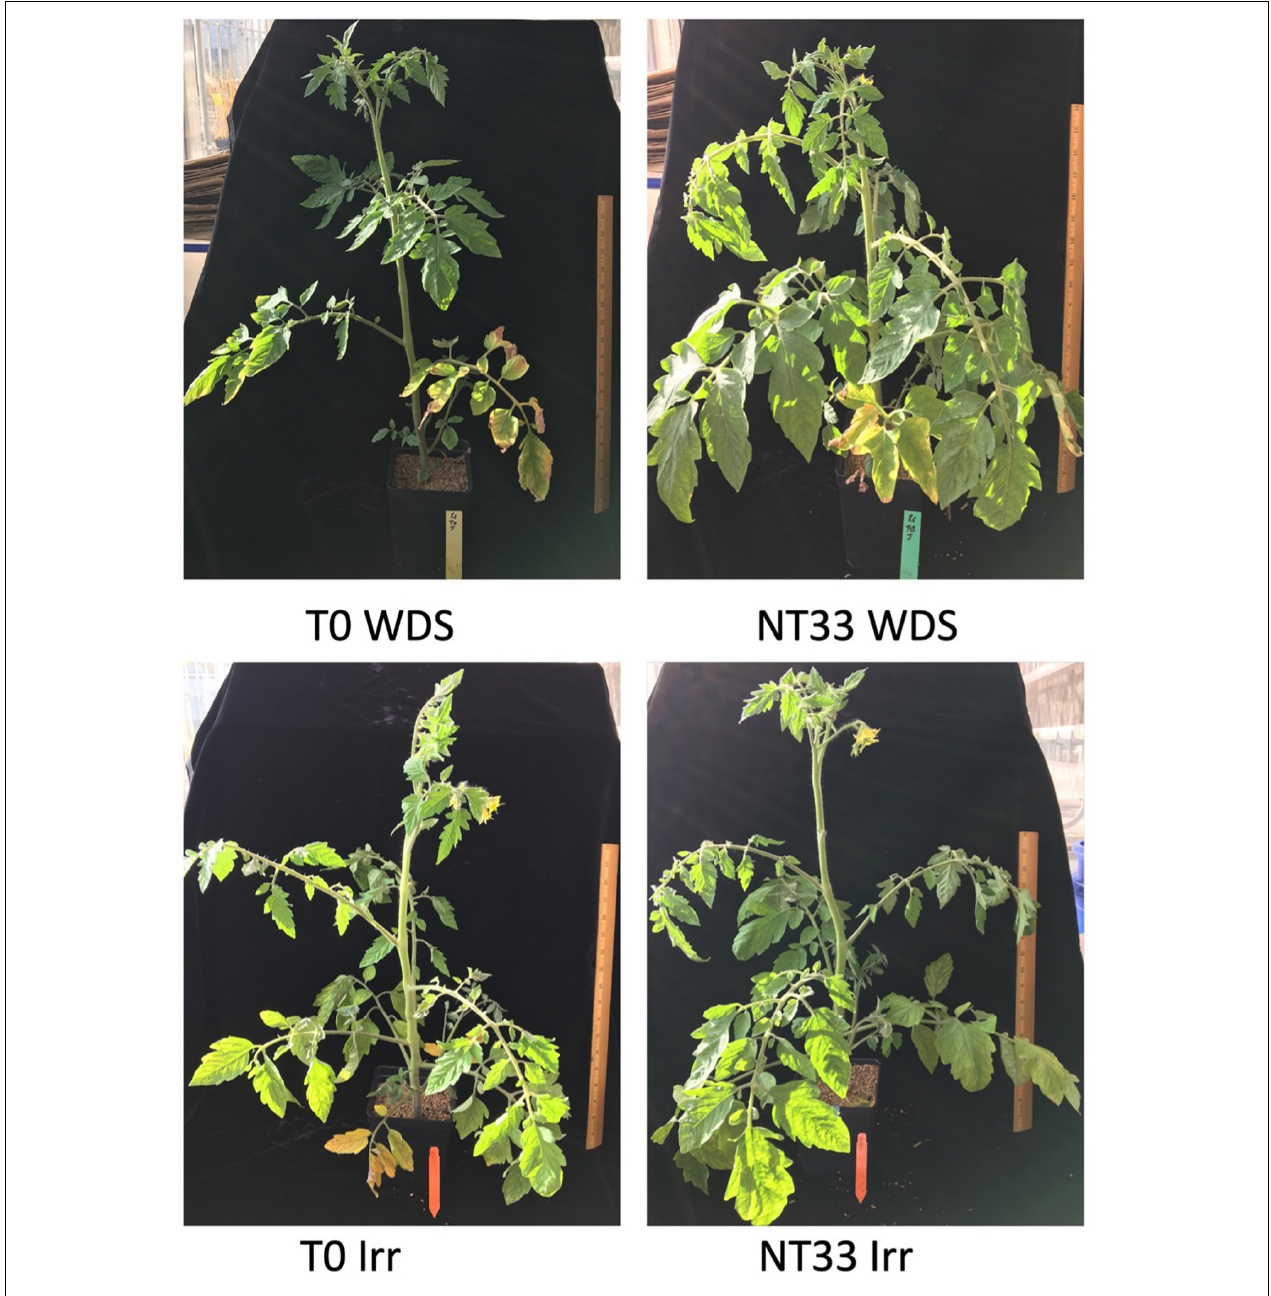
FIGURE 5 | Example ‘Jaune Flamme’ tomato plants grown under different Trichoderma inoculation and water deficit stress treatments. NT33, T. asperelloides isolate. T0WDS, non-inoculated water stressed plants; NT33WDS, NT33 inoculated water stressed plants; T0 Irr, non-inoculated irrigated plants; NT33 Irr, NT33 inoculated irrigated plants. Images were obtained after recovery from water deficit